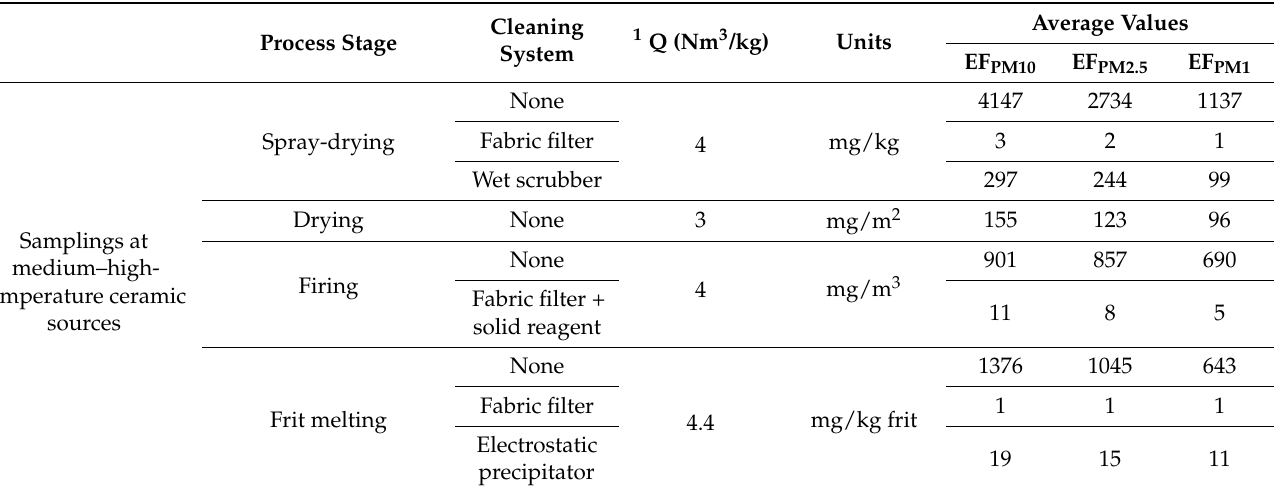
Table 7. Emission factors for spray-drying, drying, firing, and frits melting (medium- and high- temperature processes).